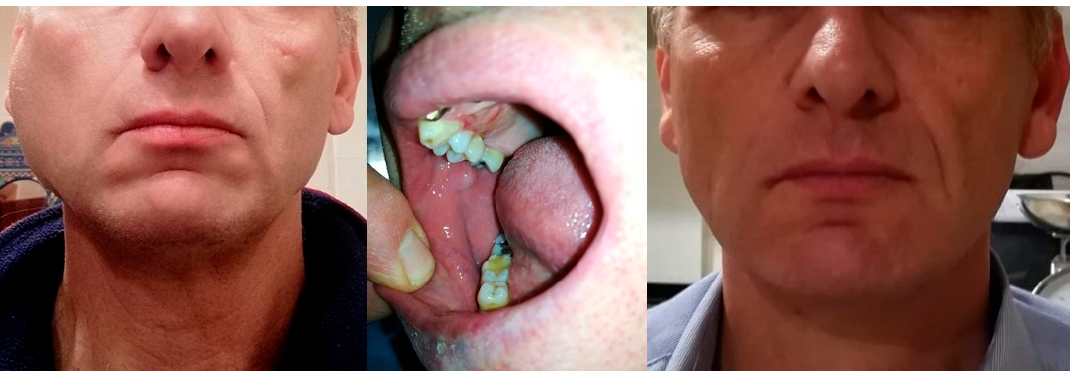
Figure 2. A male patient, 55 years old, undergoing a periodic follow-up after the telematic first visit. A diagnosis of sialolithiasis was performed by analyzing medical history and patient photos. Behavioural instructions and pharmacological therapy were given to the patient. Photo collection showed facial swelling in the right parotid region and intraoral condition with swelling of the Stenone duct at the first consultation; face healing occurred after two weeks.